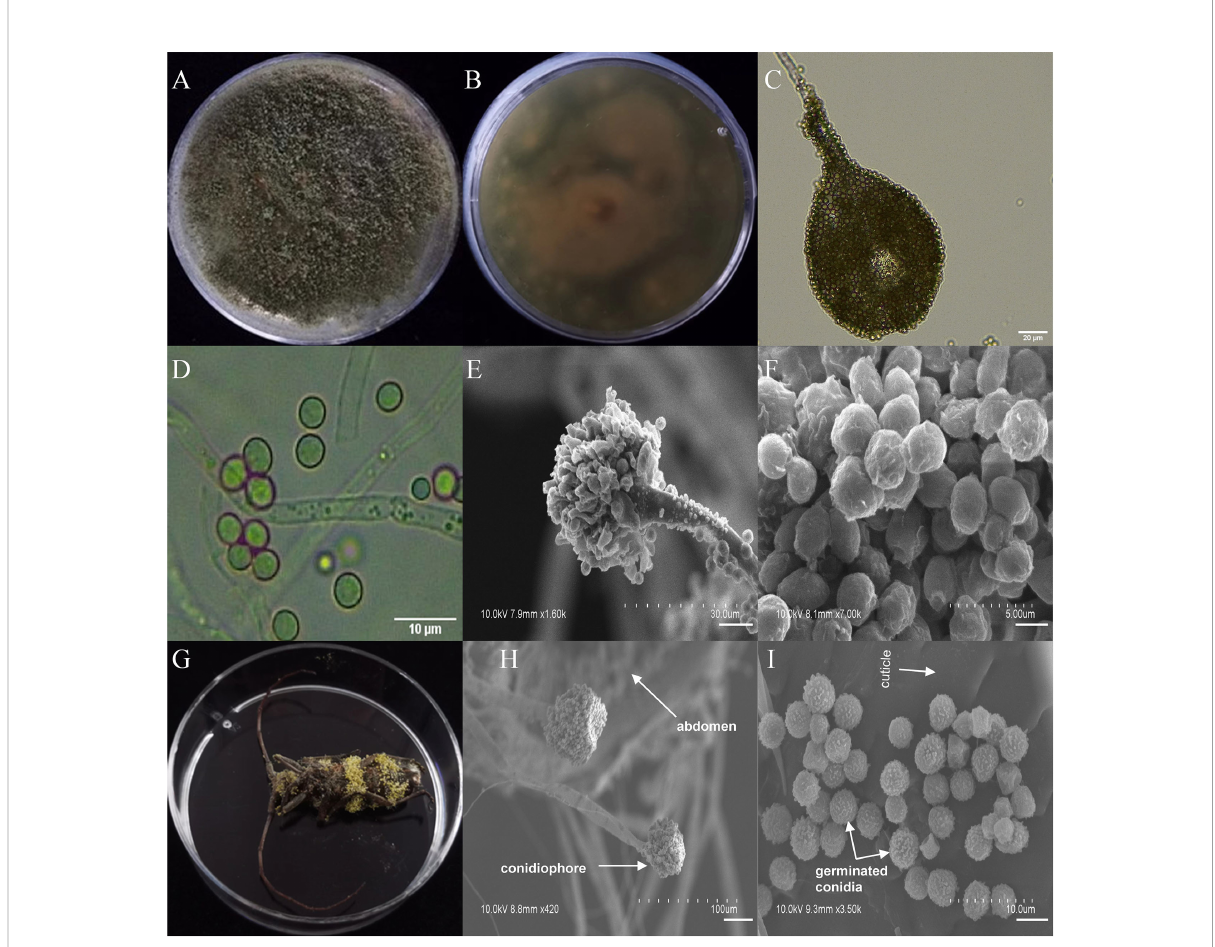
FIGURE 3 Morphology of A . austwickii and M . alternatus cadaver infected by A . austwickii under optical microscope and SEM. (A) Colonial morphology cultured on PDA. (B) Reverse of colony on PDA. (C) Hyphae and conidiophores (OM). (D) Conidia (OM). (E) Conidiophores (SEM). (F) Conidia (SEM). (G) M . alternatus cadaver surrounded by mycelia. (H) Conidiophores grown from M . alternatus cuticle (SEM). (I) Conidia on M . alternatus cuticle surface